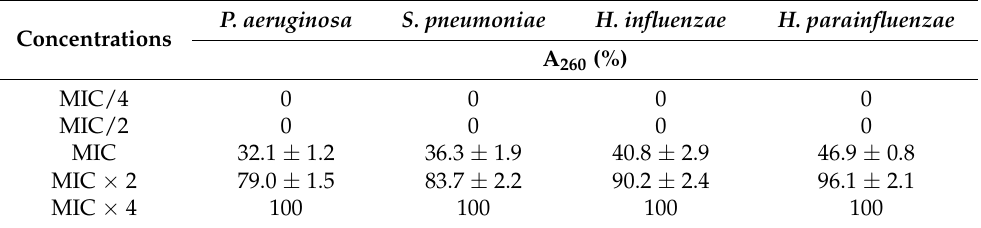
Table 3. The effect of immortelle EO at different concentrations on the release of cellular material, absorbing at 260 nm.